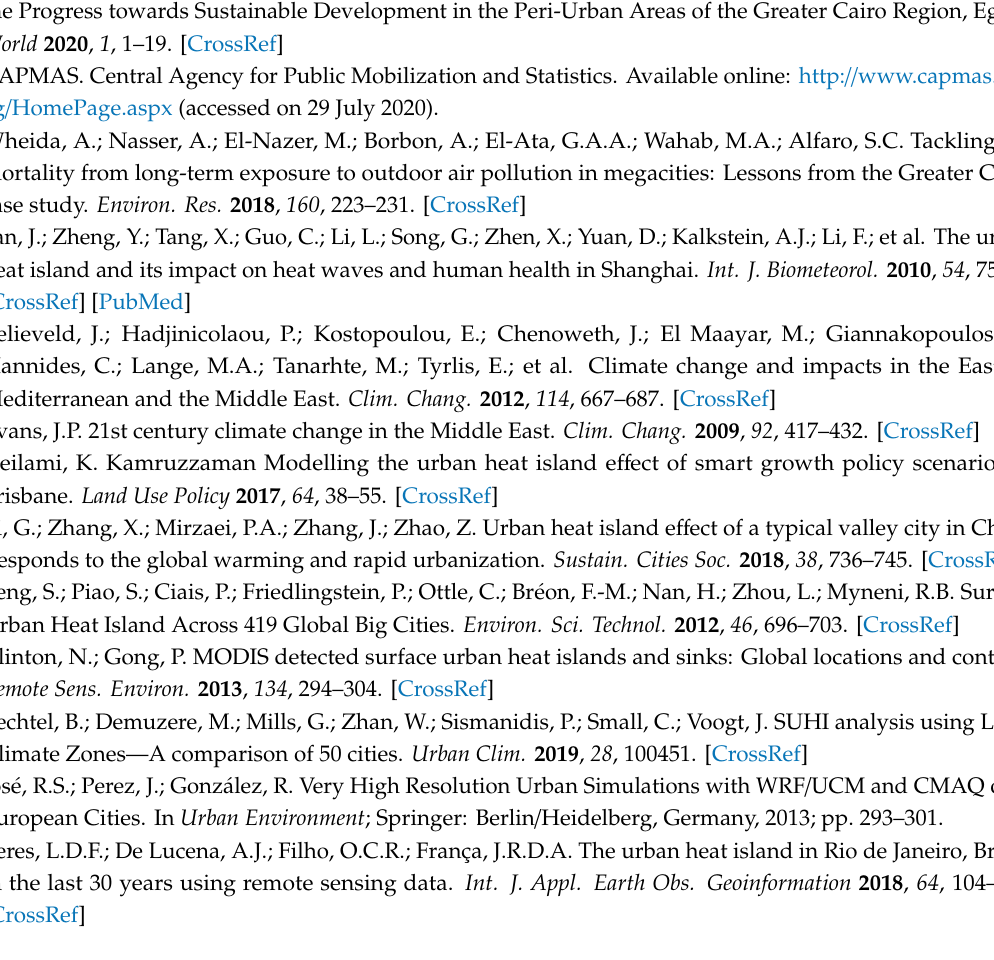
Figure S1: Spatial distribution of the dominant LCLU types in Greater Cairo in 2018. The road network and water channels are illustrated separately in the right panel. Figure S2: Averaged intensity of nighttime LST anomaly over urban and suburban areas from 2003 to 2019. The vertical dotted line indicates the mean for all grids. Figure S3: Seasonal changes (% / decade) of albedo between 2003 and 2019. Figure S4: Seasonal changes (index unit / decade) of NDVI between 2003 and 2019. Figure S5: Seasonal changes ( ◦ C / decade) of daytime LST between 2003 and 2019. Figure S6: Seasonal changes ( ◦ C / decade) of nighttime LST between 2003 and 2019. Figure S7: Seasonal changes ( ◦ C / decade) of DTR between 2003 and